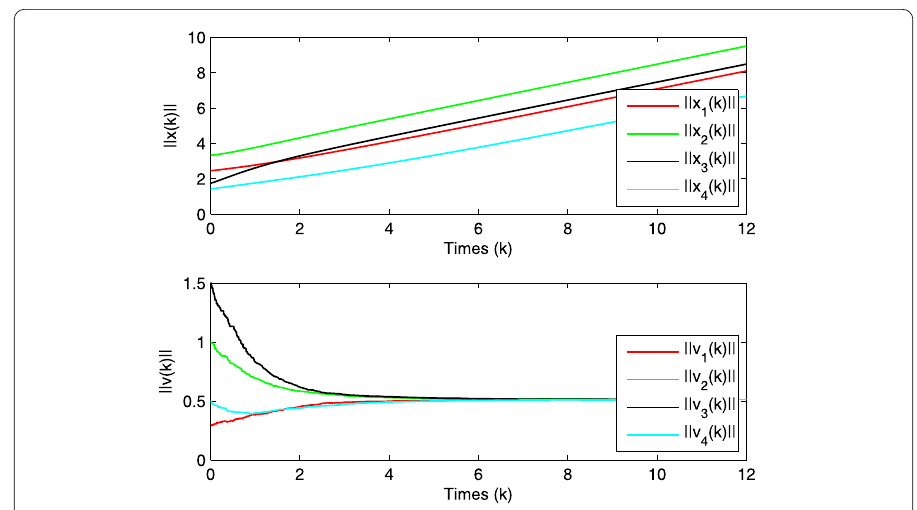
Figure 9 The norms of position and velocity trajectories with α = 1 in Case 3